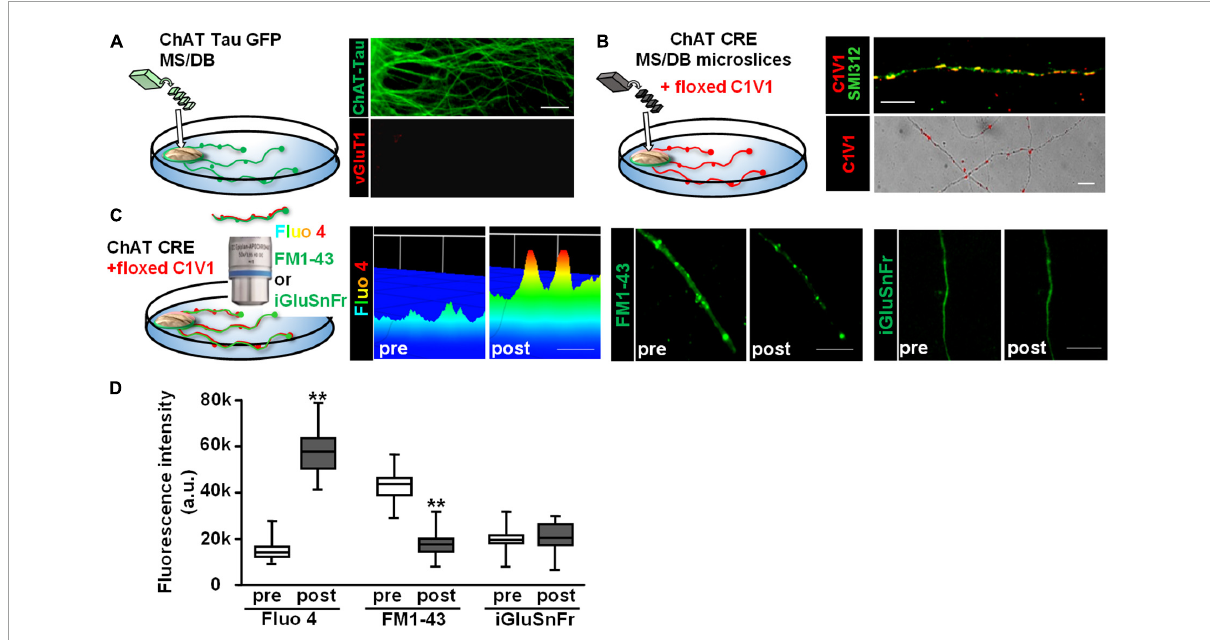
FIGURE6 Optogenetic stimulation of C1V1 expressing MS/DB cholinergic projections elicits local Ca 2 + influx and FM1-43 de-staining of cholinergic axons. (A) Schematic diagram of experimental configuration for assessing the outgrowth of cholinergic projections from thinned micro-explants of medial septum/diagonal band (MS/DB) from ChAT-tau-GFP mice. Representative confocal images of ChAT-tau-GFP fibers indicate that the projections from MS/DB micro-explants maintained in vitro are cholinergic, i.e., labeled with ChAT tau-GFP (in green, A right top) and are not marked by glutamatergic probes such as vGluT1 ( A right bottom). (B) Schematic of MS/DB slices obtained from ChAT-IRES-Cre mice (ChAT CRE) plated as micro thinned explants and then labeled with the floxed red-shifted variant of the optogenetic channel rhodopsin, C1V1 (pAAV-Ef1a-DIO C1V1 (t/t)-TS-mCherry) by in vitro infection. After 7–10 days in vitro , C1V1 labeled MS/DB projections were also labeled with pan axonal marker (SMI312). A representative confocal image shows C1V1 labeled processes detected as red puncta ( B right bottom,